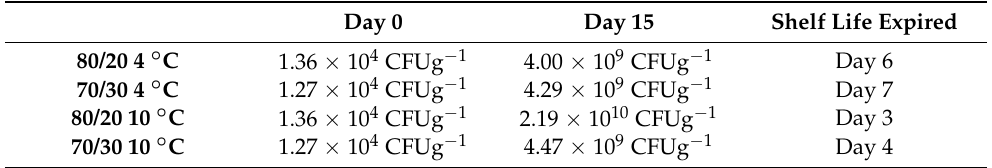
Figure 4. Development of the total viable count (TVC) for poultry stored under different storage conditions over 15 days in trays with initial gas concentrations of 70% O 2 /30% CO 2 ( (cid:78) ) and 80% O 2 /20% CO 2 ( • ) at ( a ) 4 ◦ C and ( b ) 10 ◦ C. Table 3. Total viable count (TVC) for the poultry on days 0 and 15 for each storage condition ( n = 4) and the day the critical limit of 10 7 CFUg − 1 was reached (end of shelf